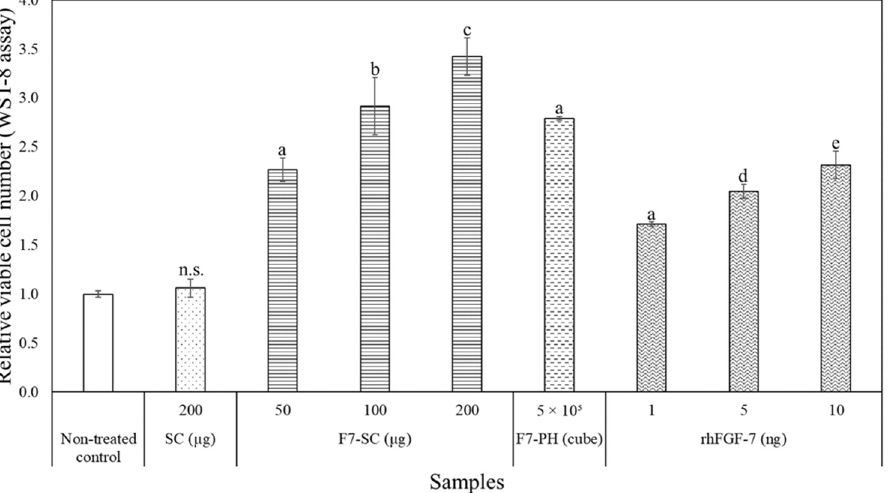
Figure 4. The proliferation of NHEK cells induced by H1/FGF-7. NHEK cells were seeded onto a 24-well plate at a density of 7500 cells per 500 µ L of DK-SFM. The culture was then supplemented with SC powder, F7-SC powder, F7-PH crystals, or rhFGF-7 and incubated at 37 ◦ C and 5% CO 2 for 3 days. The amounts of supplemented samples are indicated on the horizontal axis. Cell proliferation rates were determined as viable cell numbers (as measured using the WST-8 assay) relative to non- treated control culture with PBS only. Data are presented as means ± standard deviations (SDs) of triplicate assays. n.s p > 0.05 vs. non-treated control; a p < 0.001 vs. non-treated control; b p < 0.01 vs. 50 µ g of F7-SC; c p < 0.001 vs. 100 µ g of F7-SC; d p < 0.001 vs. 1 ng of rhFGF-7; and e p < 0.001 vs. of 5 ng of